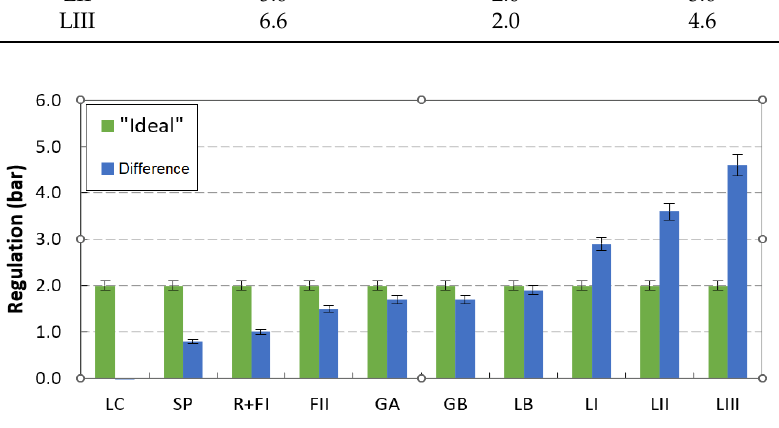
Figure 7. Ideal PRV and the difference between existing and ideal pressure regulation.